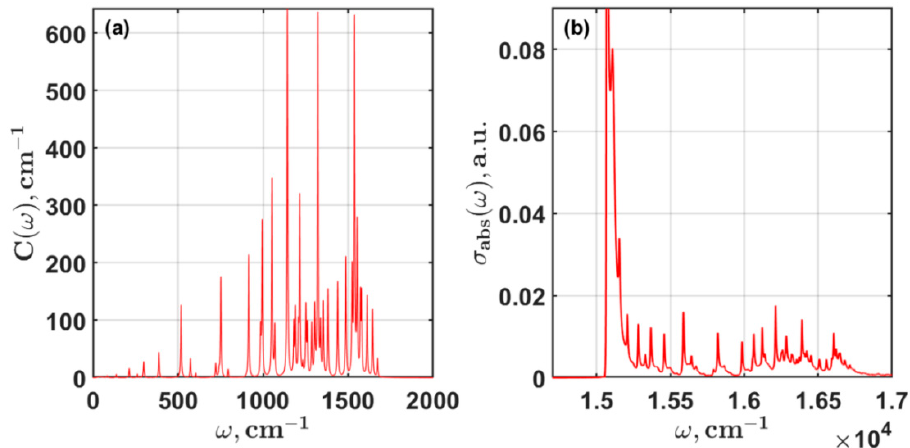
Figure 3. Chl a spectral density ( a ) and zero phonon line ( b ) at 4 K calculated according to Equation (3).